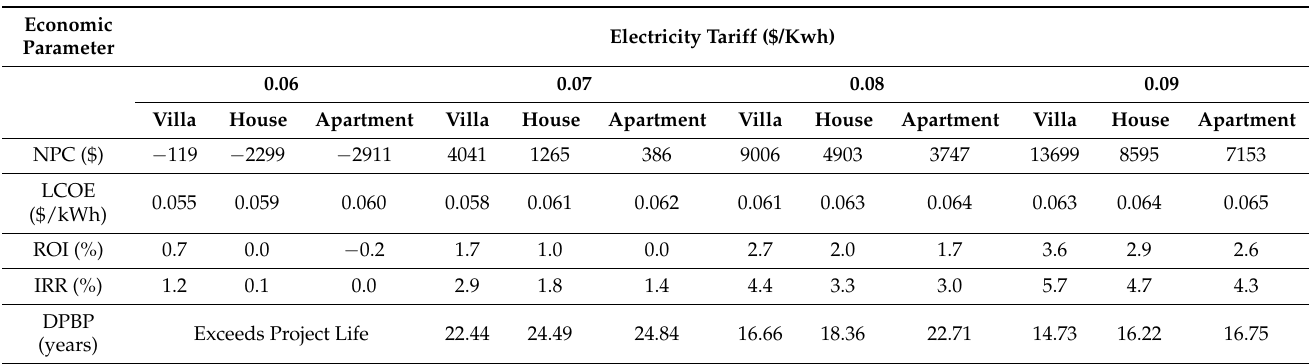
Table 3. Impact of different tariff rates on relevant economic variables for a traditional housing. Economic